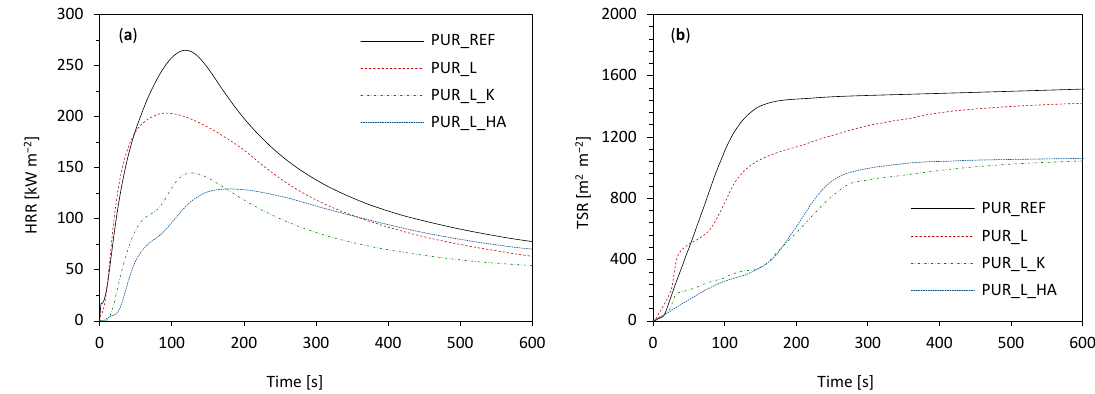
Figure 12. The results of ( a ) peak heat release rate (pHRR) and ( b ) total smoke release (TSR) measured for PUR composites.